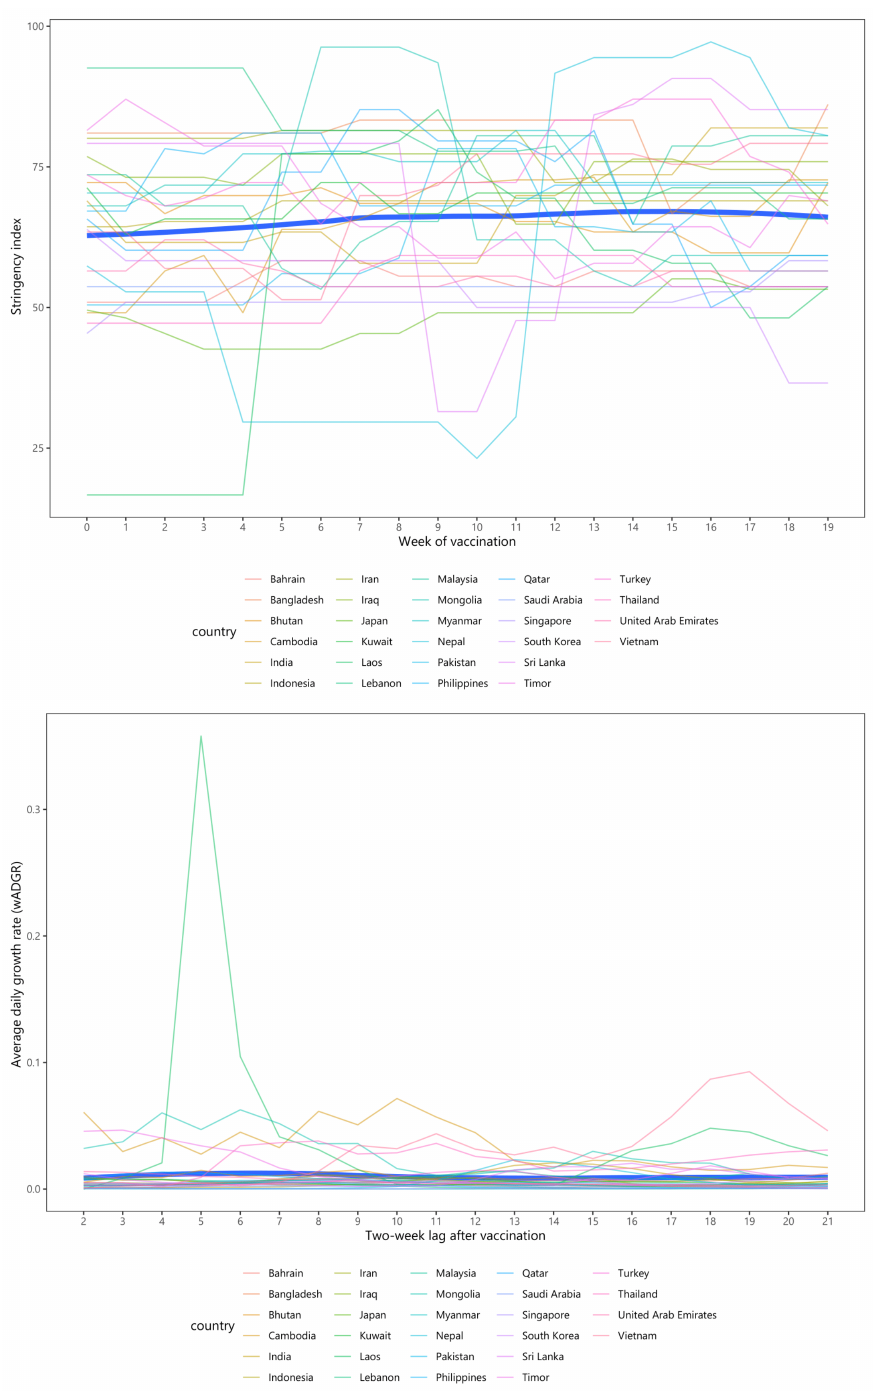
Figure 5. The evolution of stringency index and average daily growth rate (wADGR) among Asian countries during the post-vaccination